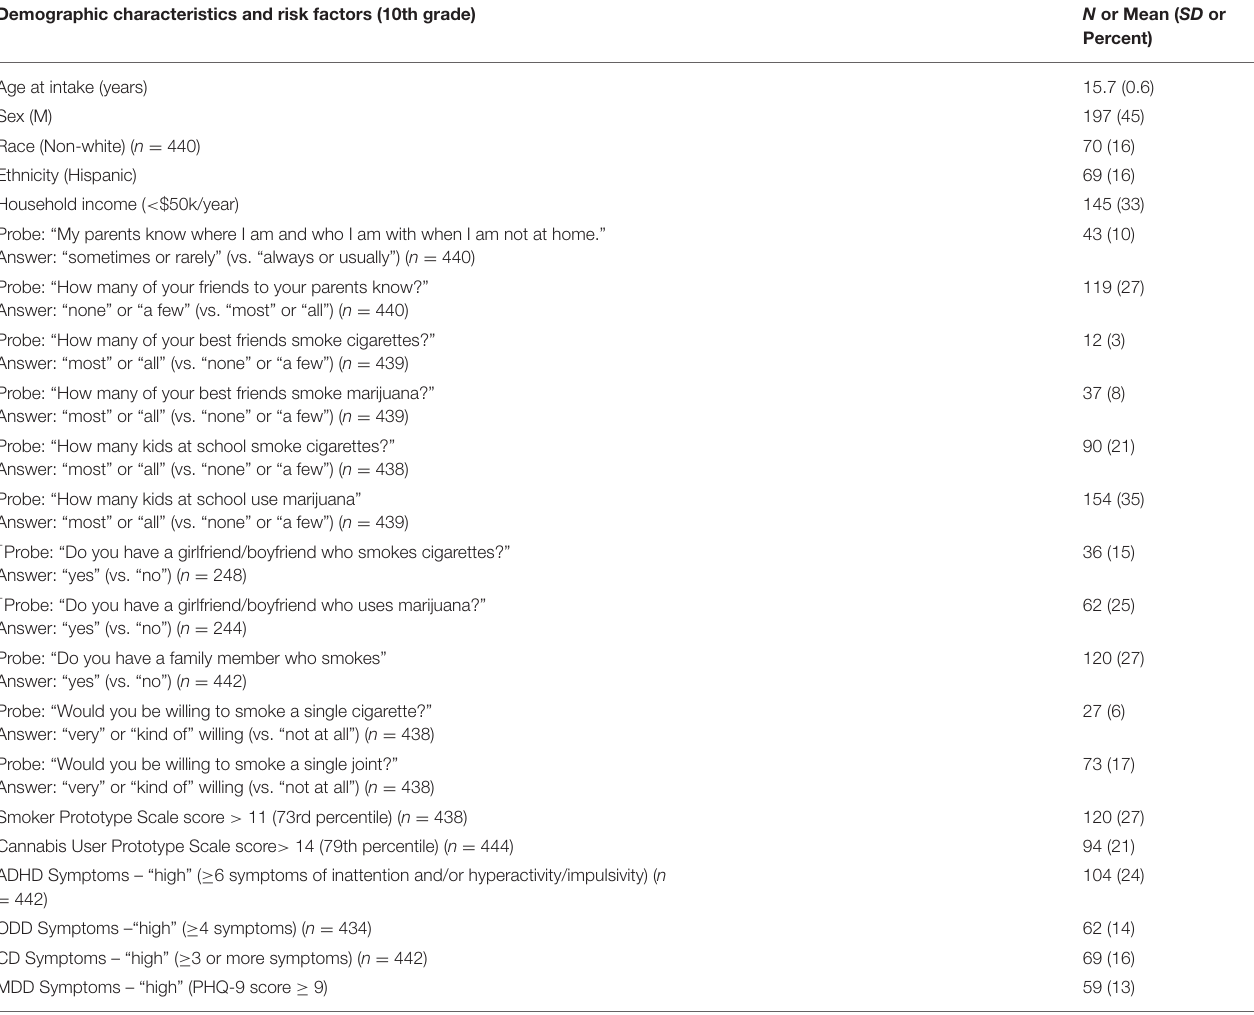
TABLE 1 | Sample demographics and environmental, and behavioral risk factors for smoking in the 10th grade ( n = 442), and odds ratios for epigenetic positivity for smoke exposure in 10–12th grade. Demographic characteristics and risk factors (10th